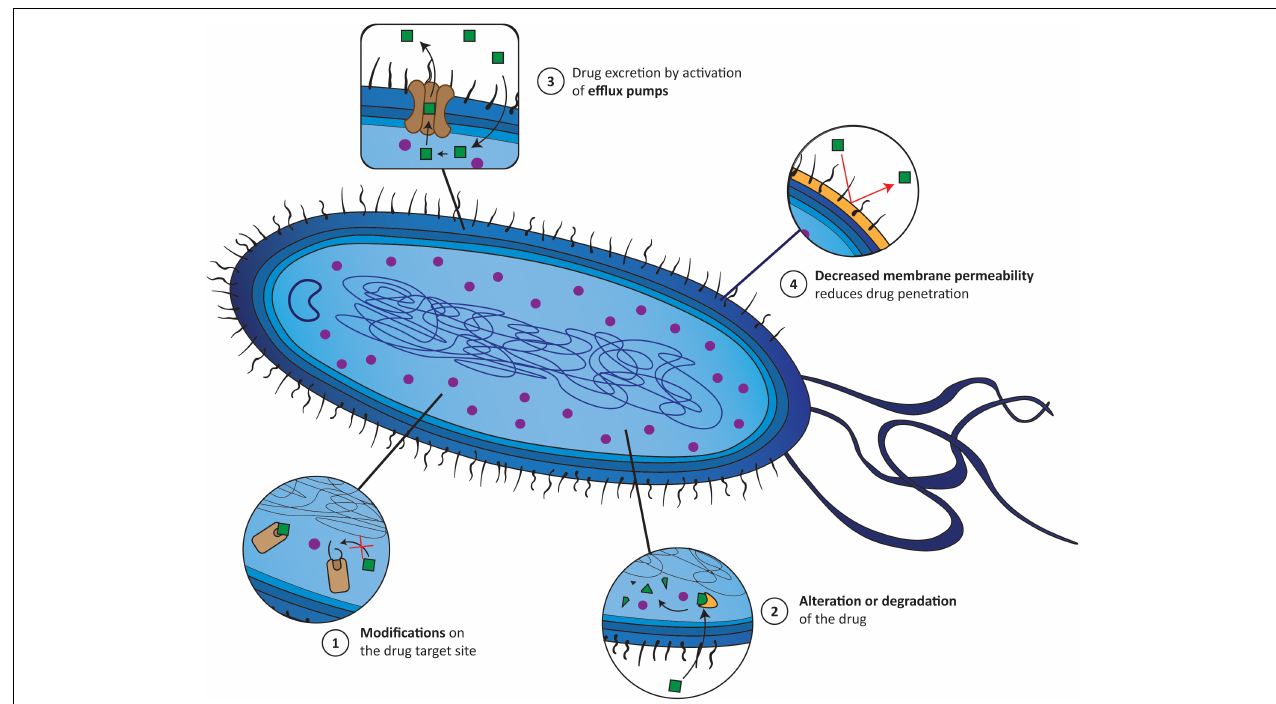
FIGURE 1 | The main mechanisms responsible for the appearance of antimicrobial resistance (AMR) correspond to (1) modifications of the target site of antibiotics; (2) alterations or even degradation of the antibiotic; (3) antibiotic efflux via efflux transporters; and (4) reduced antibiotic penetration into bacteria through decreased membrane permeability. Green squares (1–4), drug incapable of accumulating inside the bacteria; purple circle (1–4), drug accumulating inside bacteria; yellow cone (2), enzyme; yellow wall (4), bacterial